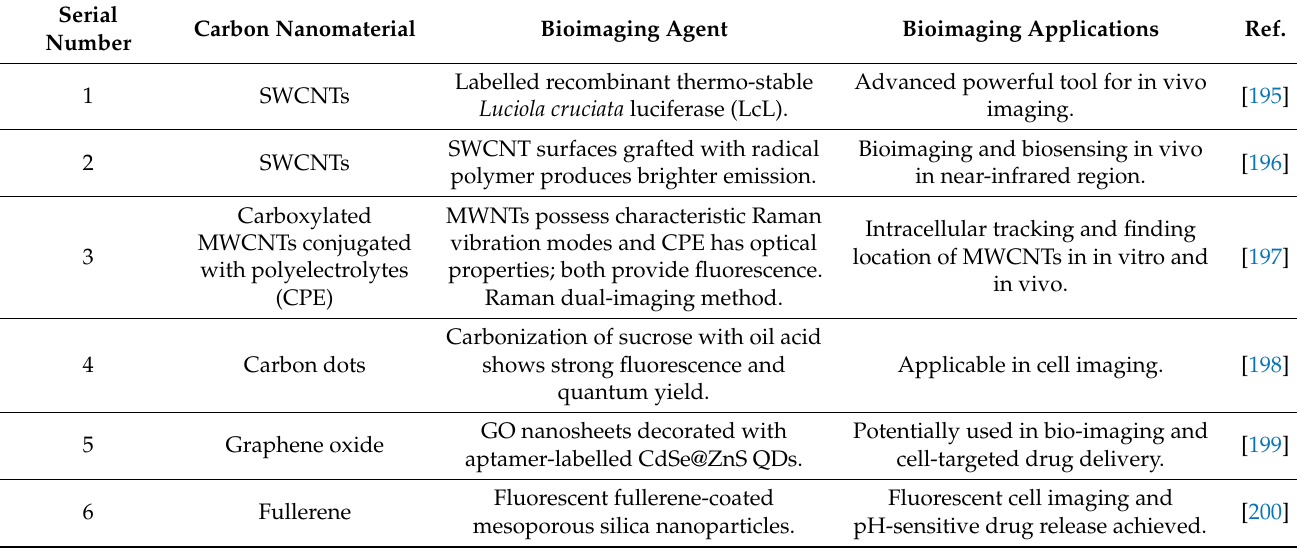
Table 7. Different uses of CNMs in bioimaging